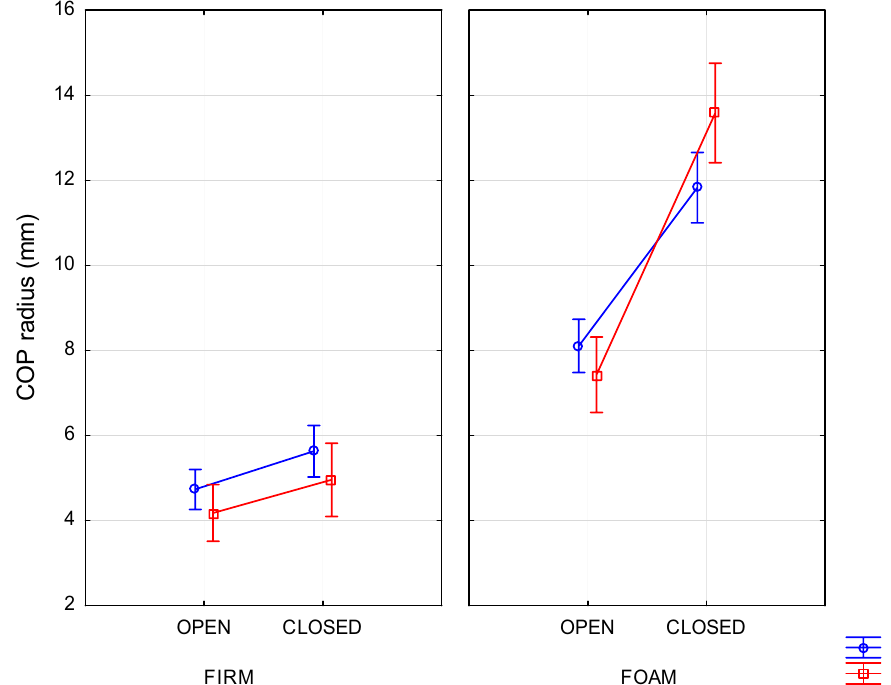
Figure 1. Group × Surface × Plane interaction (p = 0.0076) on COP radius for girls with scoliosis (AIS) and controls (CON) in trials with eyes open or closed on firm or foam surface.